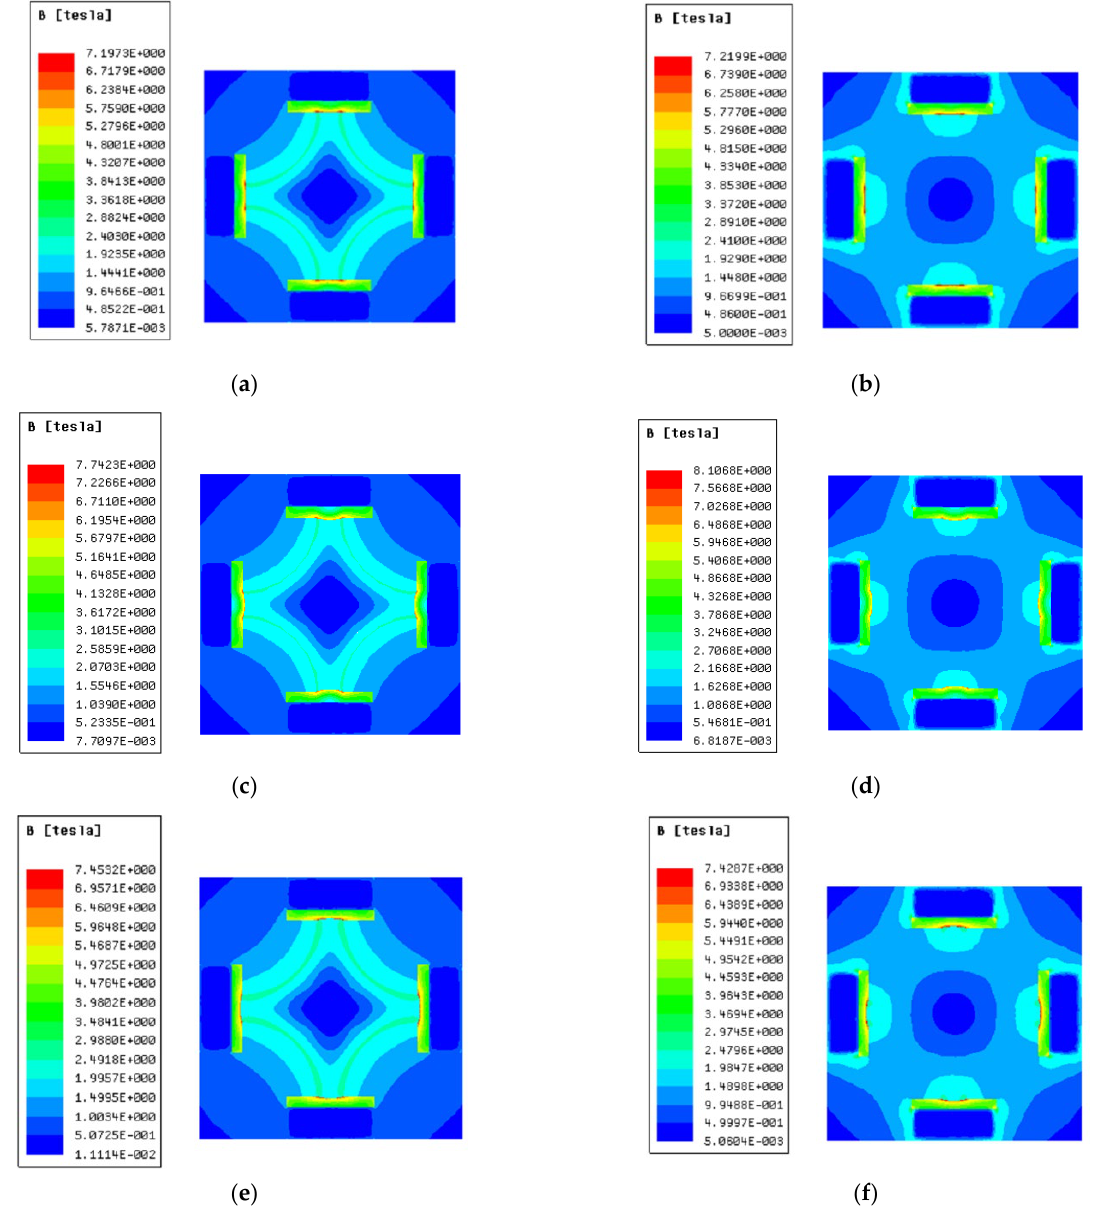
Figure 5. Magnetic field distribution of the three armature end surfaces: ( a ) flat type armature front face; ( b ) flat type armature rear end face; ( c ) front face of concave elliptical armature; ( d ) rear face of concave elliptical armature; ( e ) front face of convex elliptical armature; ( f ) rear face of convex elliptical